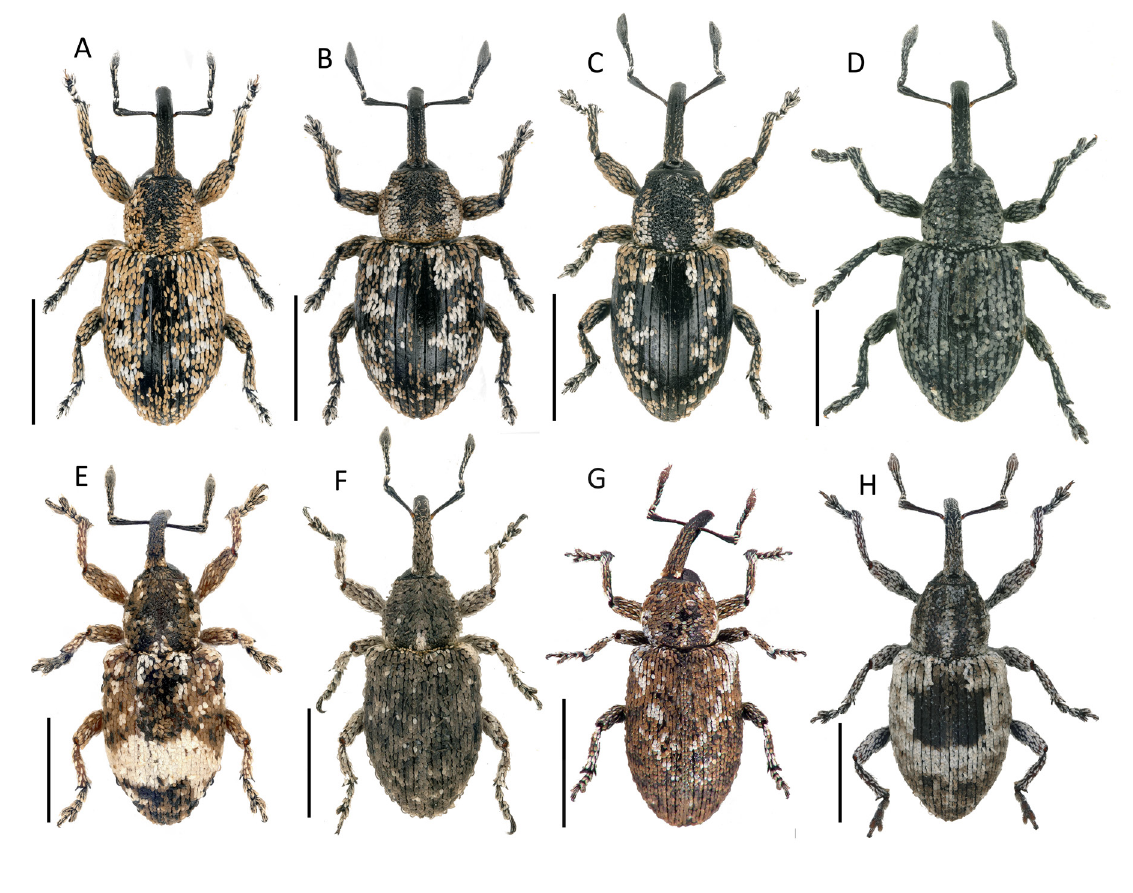
Fig. 2. Habitus of species of Smicronychini from southern Africa (Part 2). A . Smicronyx san sp. nov.,